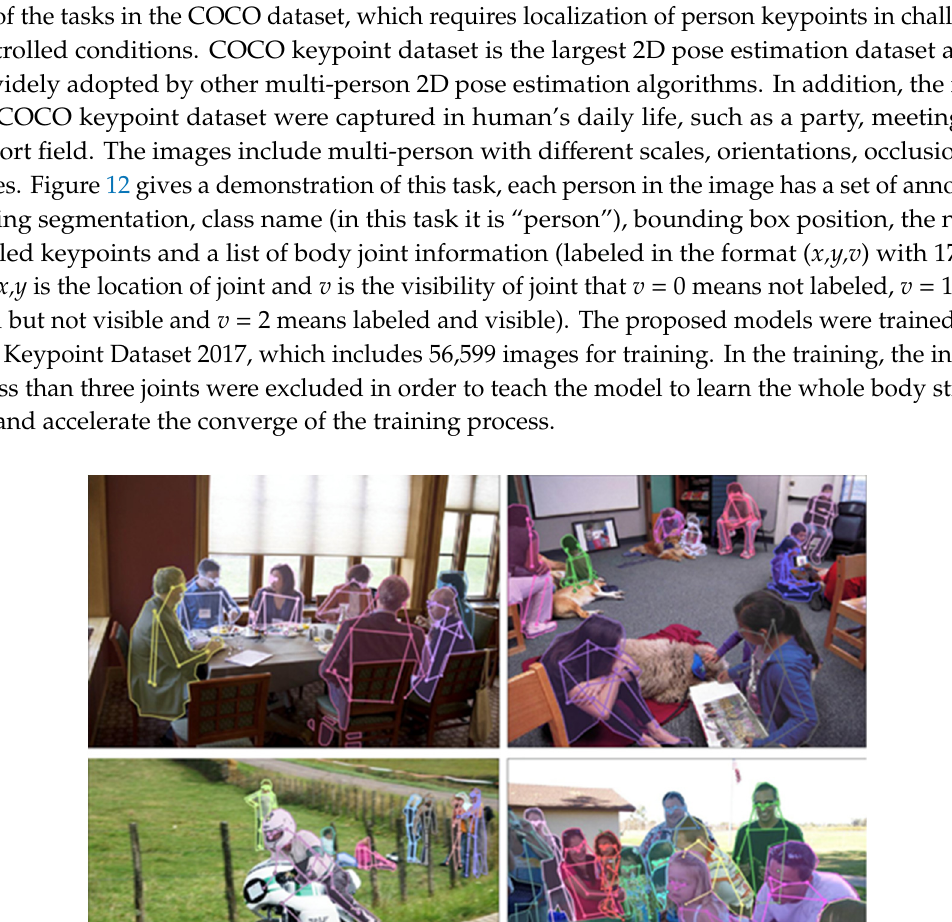
11 of 21 Figure 11. Orientation ‐ occlusion branch combined with joint position (for Figure 8a,b).